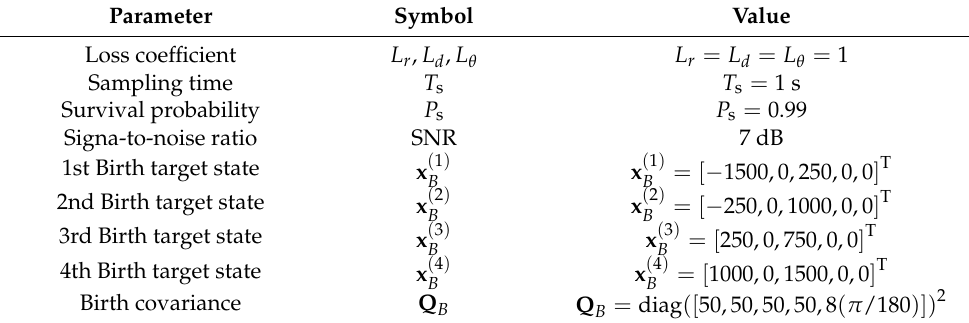
Table 1. Main parameters of the